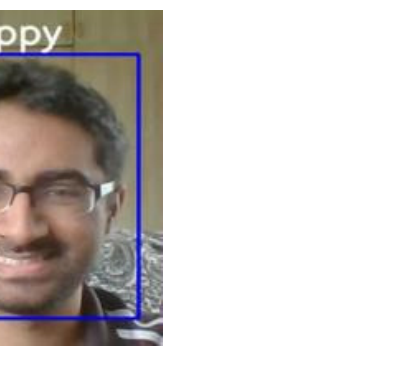
Figure 11. An example of facial expression recognition by our CNN model.